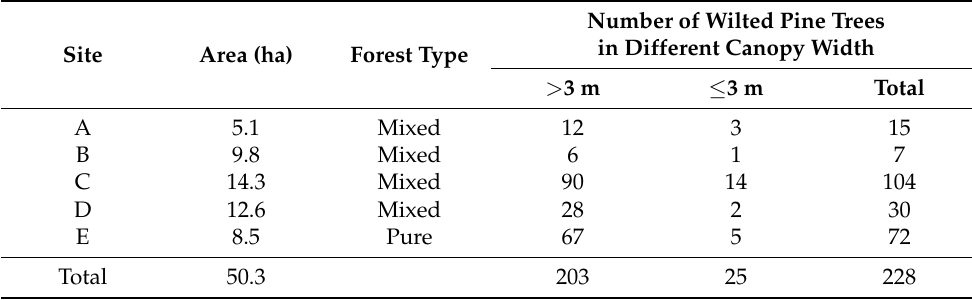
Table 1. The count of the PWD-induced wilted pine trees with different canopy width for the five field sites collected in the in situ investigations. Number of Wilted Pine Trees in Different Canopy Width Site Area (ha) Forest Type > 3 m ≤ 3 m Total 5.1